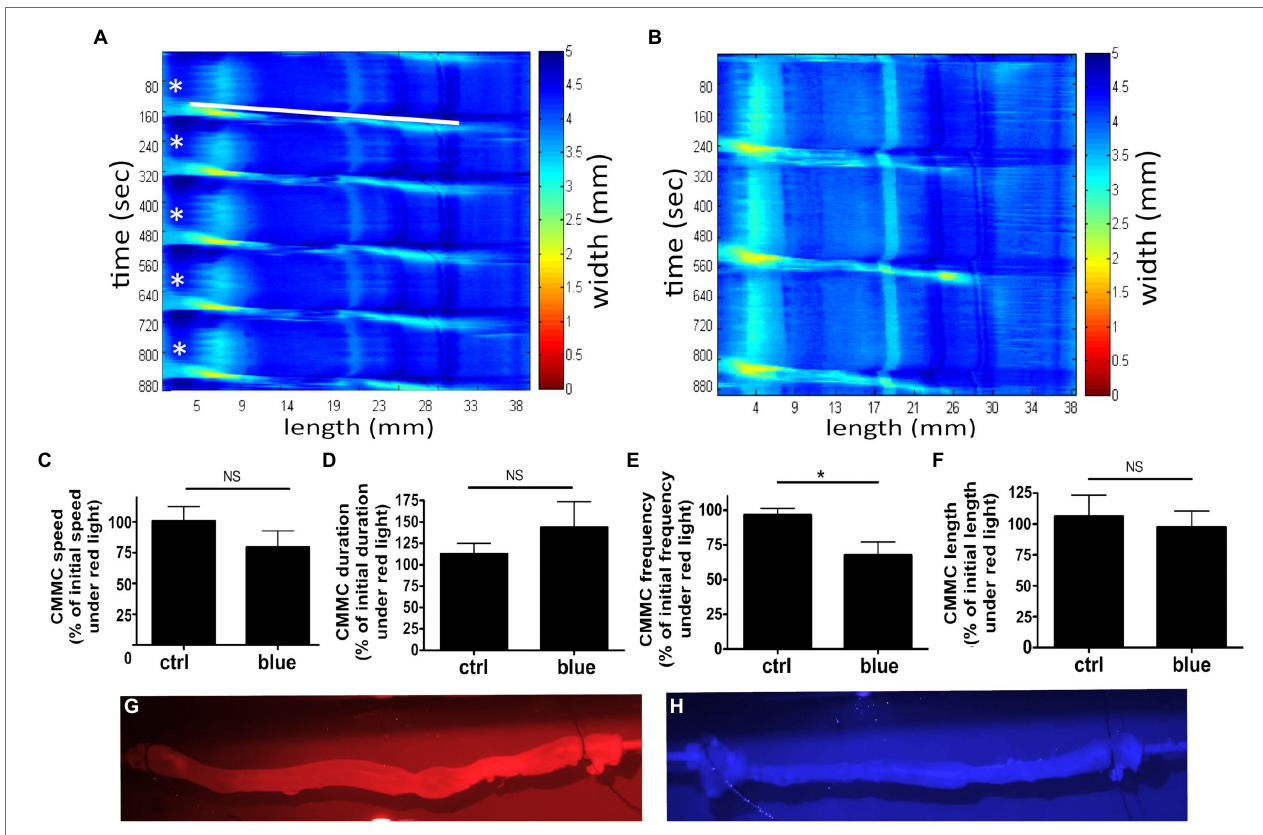
FIGURE 9 | Murine colons were pretreated with 9 -cis retinal 28 μ M and were equilibrated under 660 nm λ (red) light and baseline motility recorded. Subsequent exposure to either 435 nm λ (blue) light or red light (time decay control, ctrl) was then recorded. (A,B) Representative heat map of ctrl colon (A) or blue light- treated colon (B) , using edge detection during spontaneous colonic peristalsis. Heat map displays time on the y-axis and length along the colon on the x-axis. Color changes in the heat map indicate a change in the width of the colon at the correlating length and correlating time on the x and y-axes. The start of each colonic migrating motor complexes (CMMC) is labeled in (A) with a white star, and the progression of the first CMMC down the length of the colon is depicted by the white bar. (C–F) Graphical representation of measured speed, duration, frequency, and length of recorded colonic motility. Ctrl represents colons recorded under red light as a percentage of their baseline red recording as a time decay control. Blue represents blue light-treated colons as a percentage of their baseline red recording. (E) Frequency of CMMC decreased more with blue light exposure to 68 ± 9.4% of baseline, while ctrl decreased to 97 ± 4.6% of baseline (* p < 0.05, n = 5–9). (G,H) Captured frames of video recording colonic motility during red and blue light exposures demonstrating the captured visual quality under each lighting